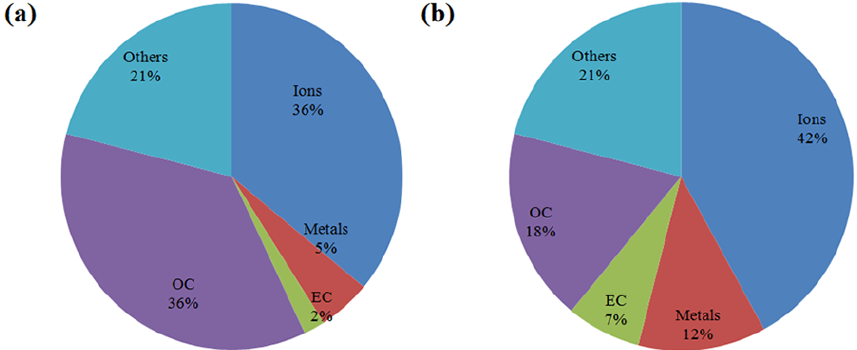
Figure 3. Mass balance of TSP sampled during haze (a) and clear days (b) at St. John’s Island in